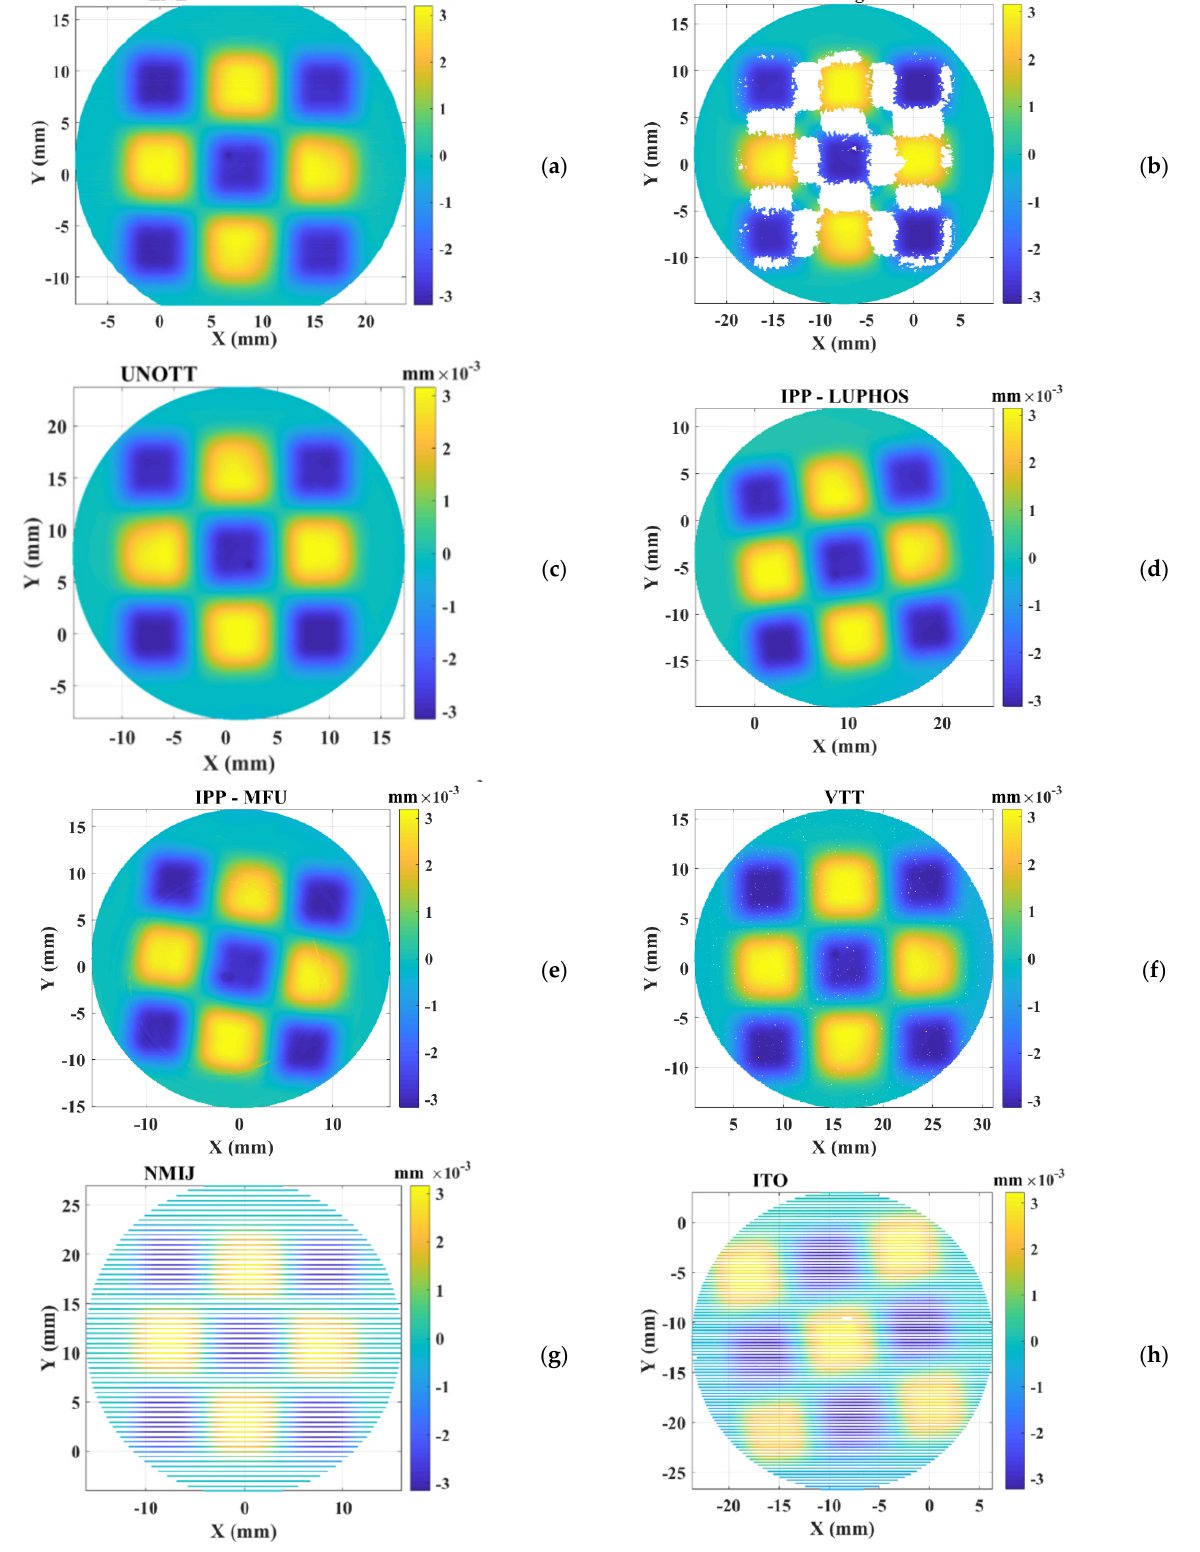
Figure 10. Illustration of the obtained residuals when applying the implemented robust reference minmax fitting algorithm on measured datasets (TIMM-1) using the described ultra-high precision measurement machines at LNE ( a ), Thales-Agx ( b ), UNOTT ( c ), IPP-LUPHOS ( d ), IPP-MFU ( e ), VTT( f ), NMIJ ( g ) and ITO ( h